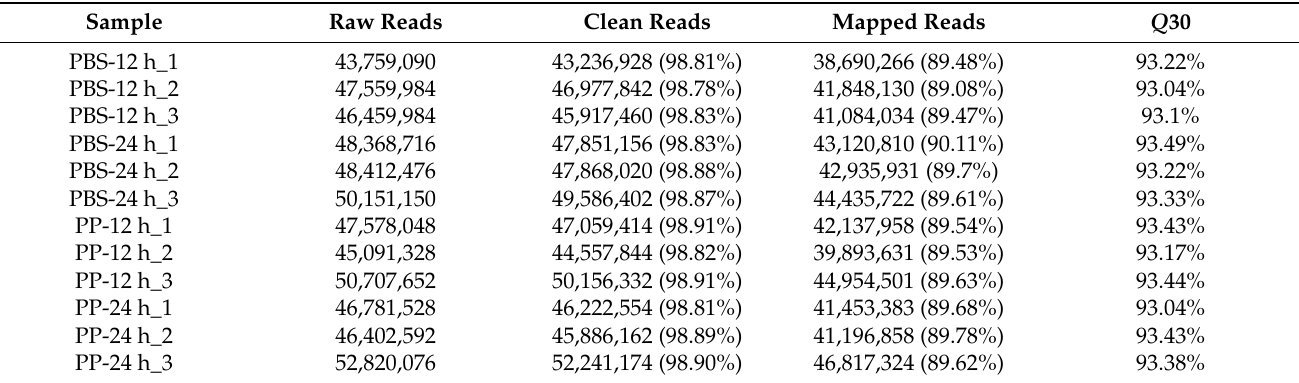
Table 2. Summary of the RNA-seq dataset.